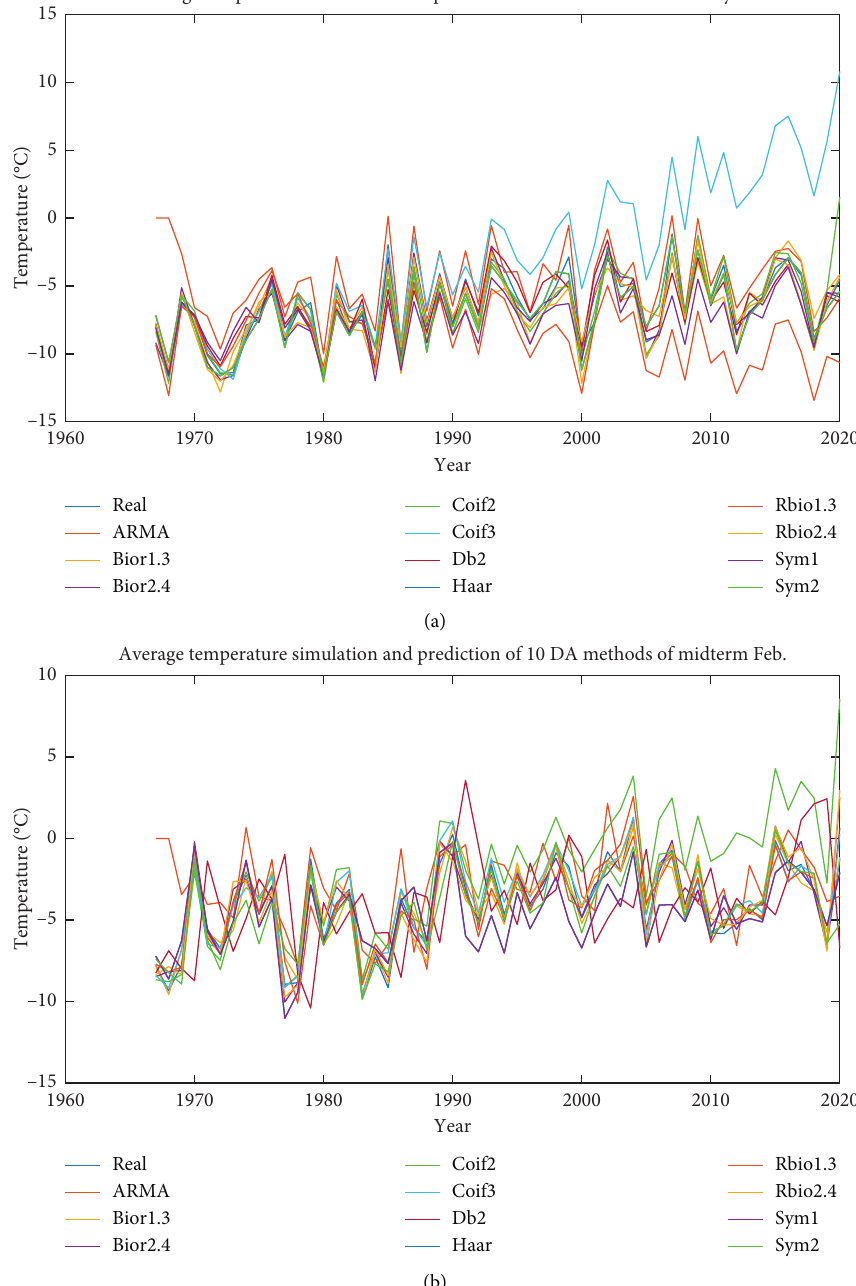
Figure 1: The calculation of 10 DA and 1 traditional ARMA